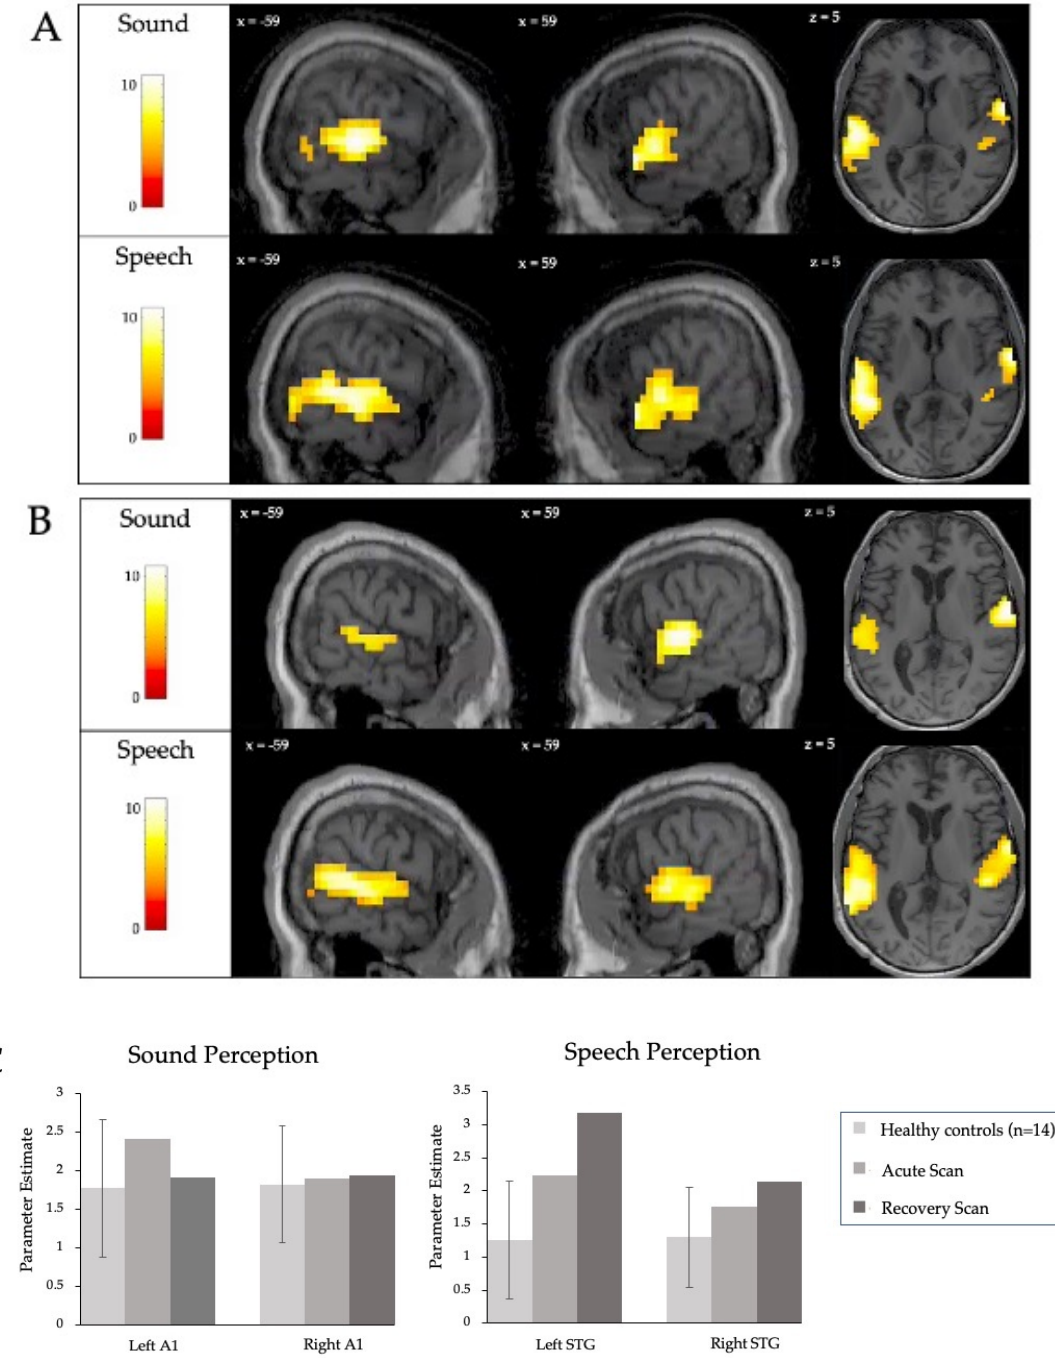
Figure 3. Auditory perception acutely and at recovery. ( A ) Neural responses to the auditory perception paradigm in acute brain injury *. ( B ) Neural responses to the auditory perception paradigm 9-months post-injury *. ( C ) The patterns of activity in the auditory perception paradigm corresponding to the peak voxel co-ordinates in each contrast. The acute scan and recovery scan parameters are plotted adjacent to the mean activity of 14 healthy participants [13]. The error bars indicate the standard deviation of the healthy controls. * Individual patient results are thresholded at p < 0.05, FWE corrected for multiple comparisons.